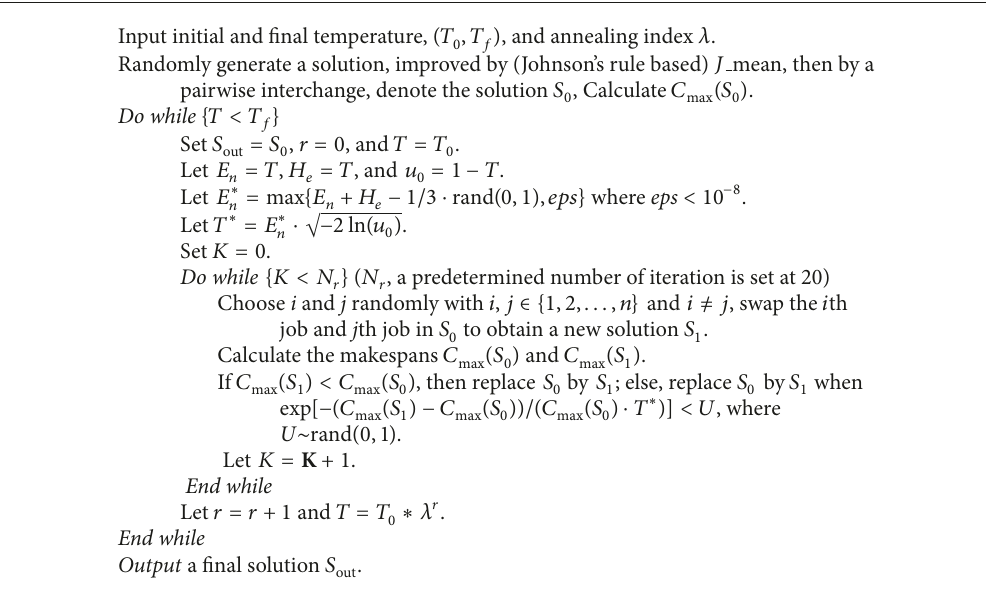
Algorithm 1: Procedure of the proposed CSA.